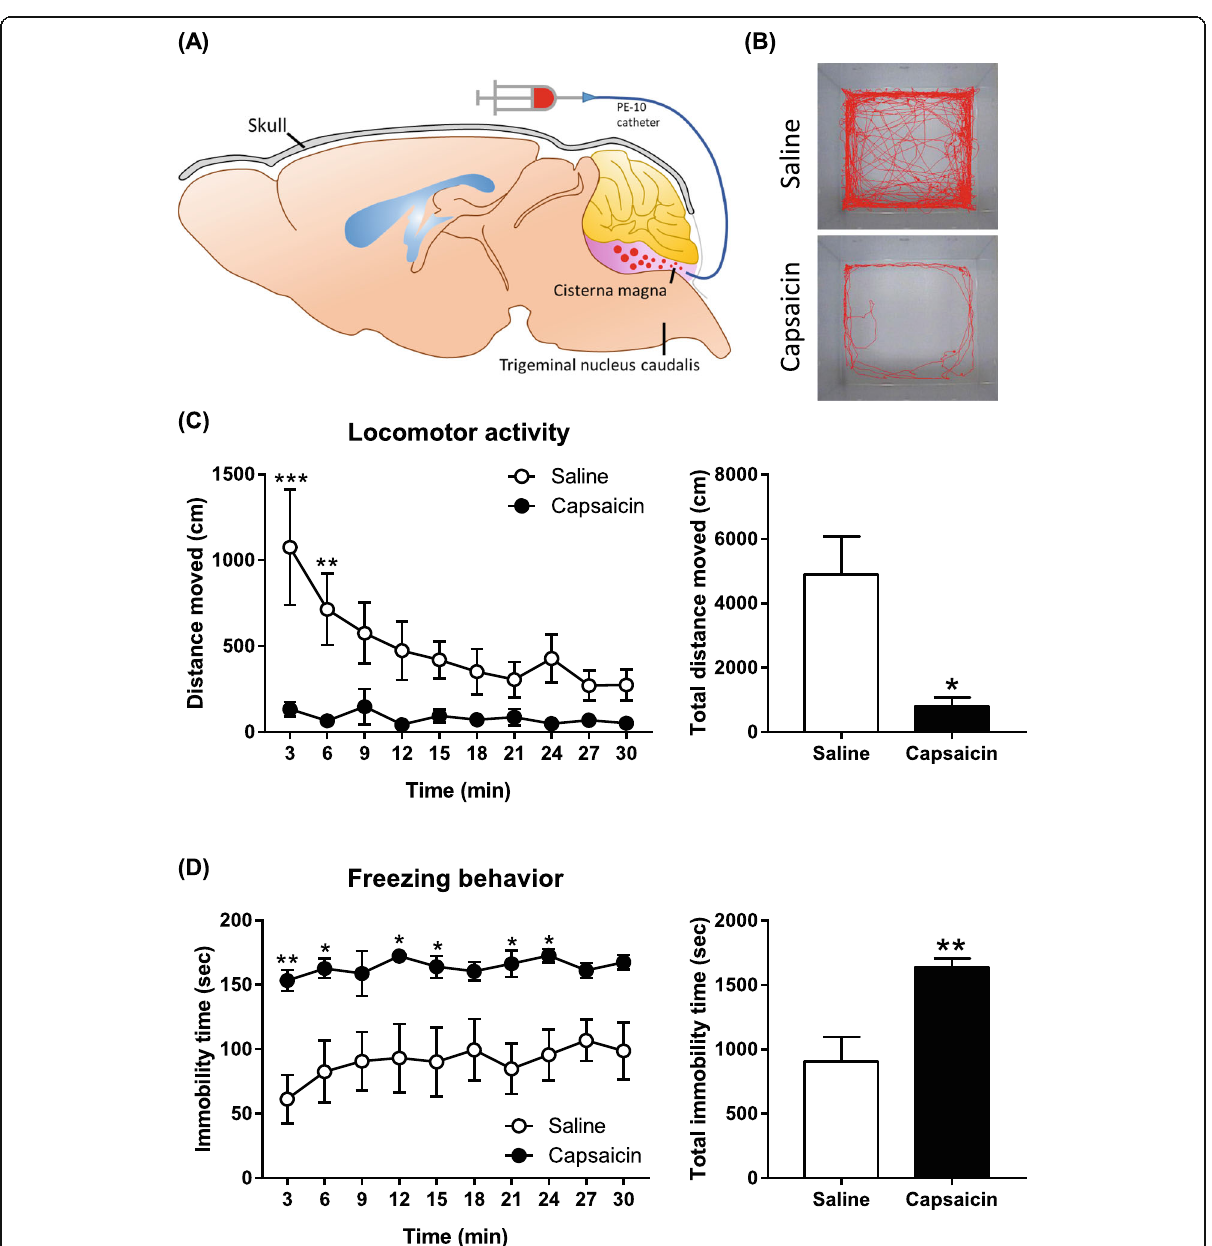
Fig. 1 Intracisternal capsaicin injection-induced spontaneous headache-related pain behaviors. Mice were injected with capsaicin into the cisterna magna to induce headache symptoms. The spontaneous headache-related pain behaviors, locomotor activity and freezing behavior, were evaluated 90 min after capsaicin infusion. a The illustration of injection site in the cisterna magna. b The trace of body movement after saline or capsaicin injection. c The locomotor activity was calculated by the distance that mice moved (cm) in every 3 min for a total session of 30 min. Bar graph illustrates cumulated counts within 30 min. d The freezing behavior was calculated by the mice immobility time (sec) in every 3 min for a total session of 30 min. Bar graph illustrates cumulated counts within 30 min. Data are represented as mean ± SEM and were analyzed by two- way ANOVA with Bonferroni ’ s multiple comparison test or unpaired Student ’ s t-test. * p < 0.05, ** p < 0.01, *** p < 0.001, comparing capsaicin and saline treated groups ( N = 5 per